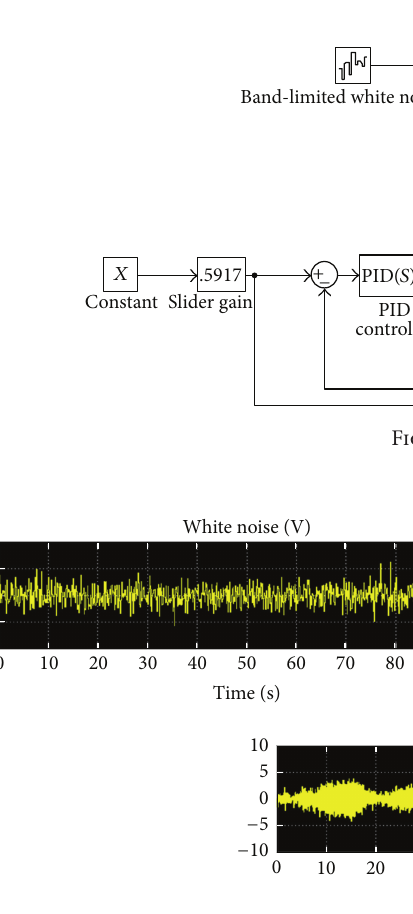
Figure 4: Response with P controller with proportional gain of 8875.1 and white noise of 0.01 volts.